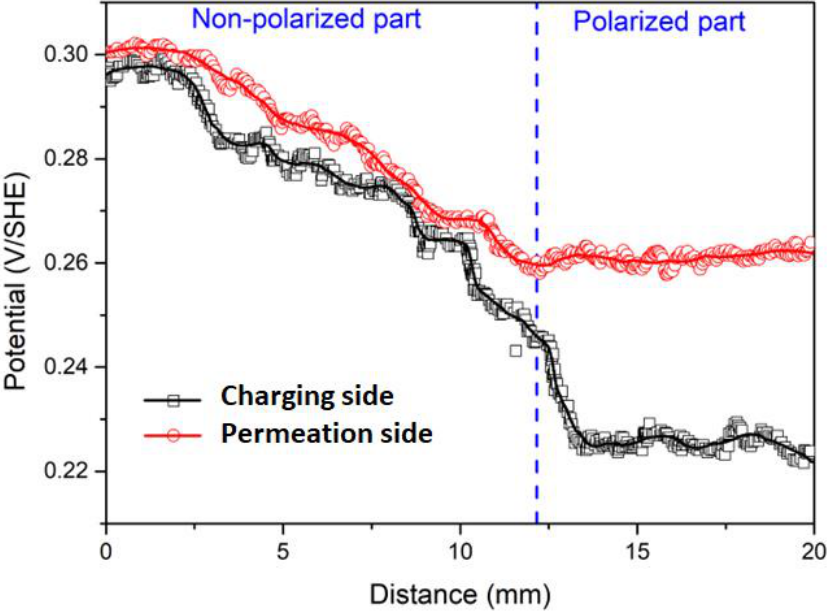
Figure 11. Linear scans across the directly polarized and permeation sides of an HSS 1500 membrane, after treatment of − 5 mA/cm 2 in 1 M NaOH for a duration of 4.4 h. The sample was exposed to dry air for 10 days and then ground with emery paper. SKP linear scans were measured 24 h after grinding.